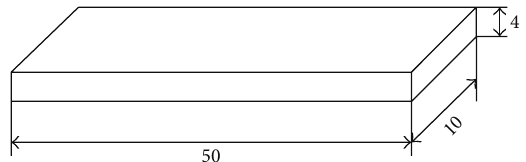
Figure 3: Beam-shaped sample, with its dimensions, used for the DMA